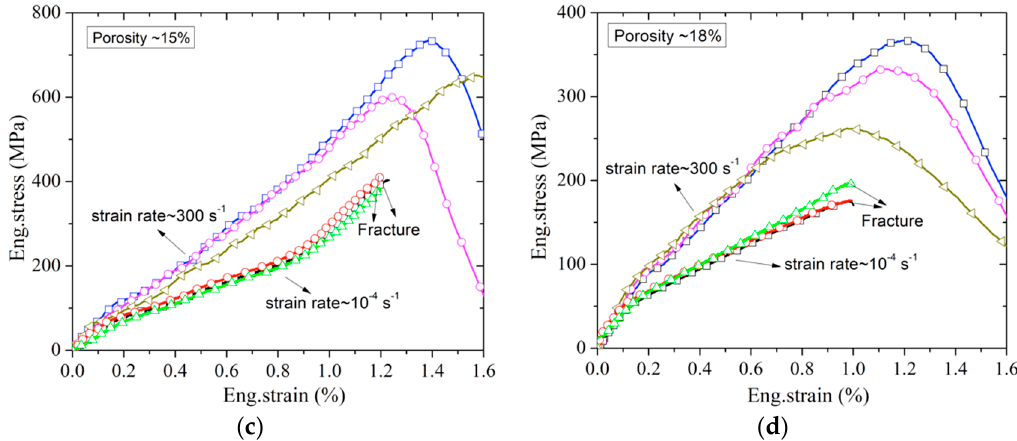
Figure 9. Eng.stress–eng.strain curves of poled PZT95/5 with different porosities at the strain rate of ≈ 300 s − 1 and ≈ 10 − 4 s − 1 : ( a ) porosity ≈ 5%; ( b ) porosity ≈ 11%; ( c ) porosity ≈ 15%; ( d ) porosity ≈ 18%. The compressive strength of poled ceramics versus porosity at the strain rate of 300 s − 1 and 10 − 4 s − 1 is shown in Figure 10. From a given range of the porosity in tests, the strength at the strain rate of 10 − 4 s − 1 decreases linearly with the porosity of ≈ 5% to ≈ 15% and sharply drops at the porosity of ≈ 18% (the sharp strength drop may be related to the coalescence of pores, and the spacing between voids and between voids and defects), while the strength at the strain rate of 300 s − 1 decreases nonlinearly with the increasing porosity. It is also worth noting that with the increase of porosity, the compressive strength of poled ceramics at the strain rate of 300 s − 1 draws near the strain rate of 10 − 4 s − 1 . This indicates that the strain rate sensitivity decreases gradually with porosity.